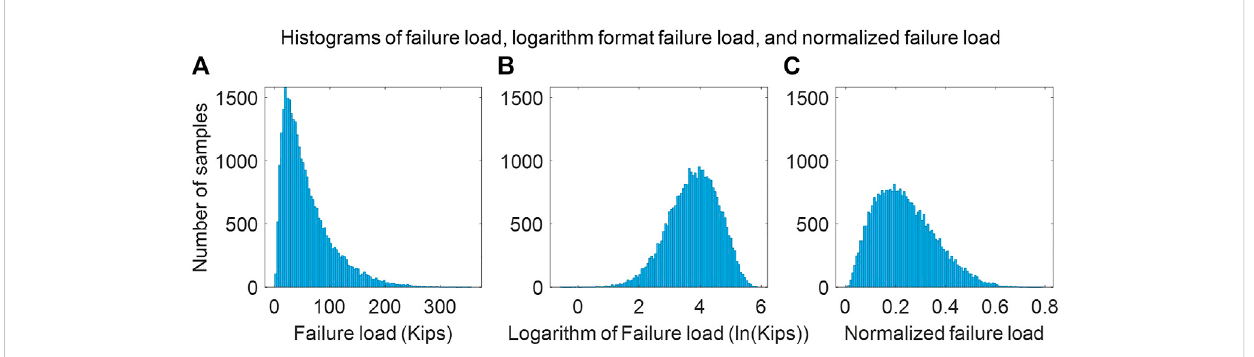
FIGURE 5 Histogramsoffailureloadvalueswiththenumberofbinsas100 – (A) histogramoforiginalfailureloadvalues, (B) histogramofthelogarithmoffailure load values, and (C) histogram of the normalized failure load